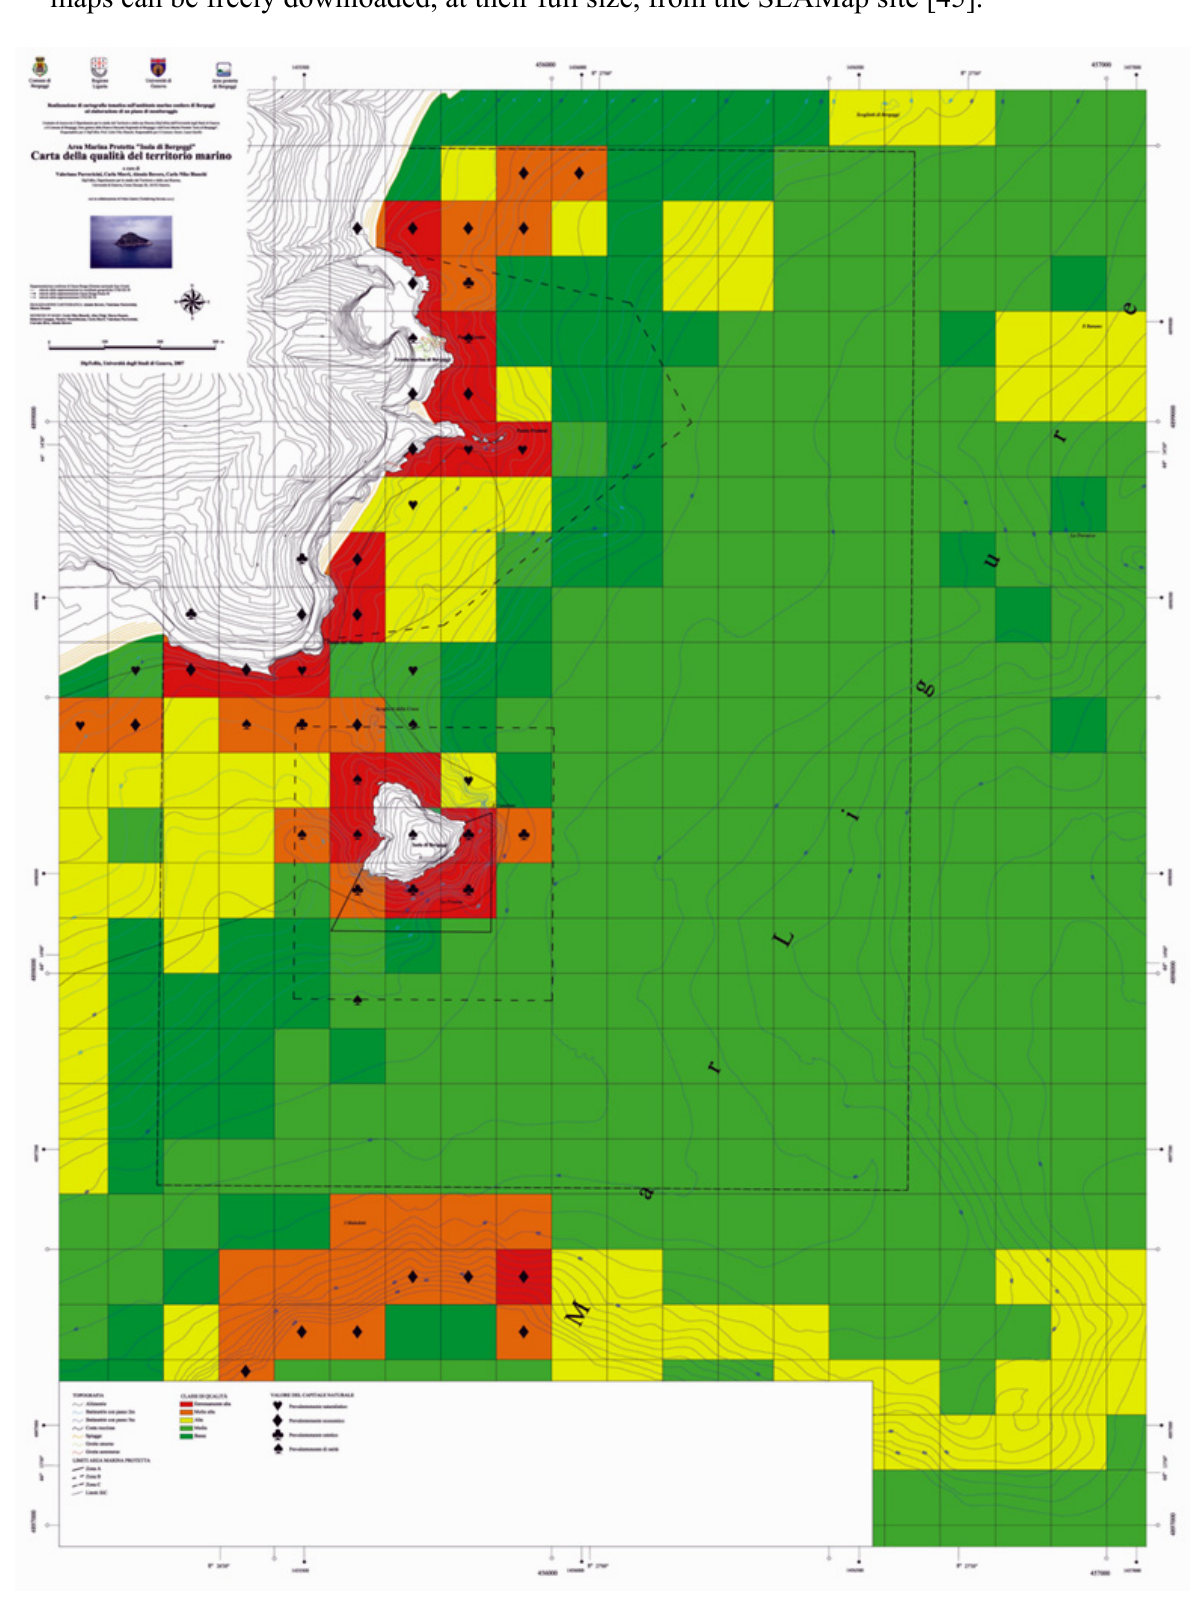
Figure 8. Reproduction at reduced scale of a map of the marine territory quality. The example illustrates the MPA “Isola di Bergeggi” (original scale 1:2,000). This and similar maps can be freely downloaded, at their full size, from the SEAMap site